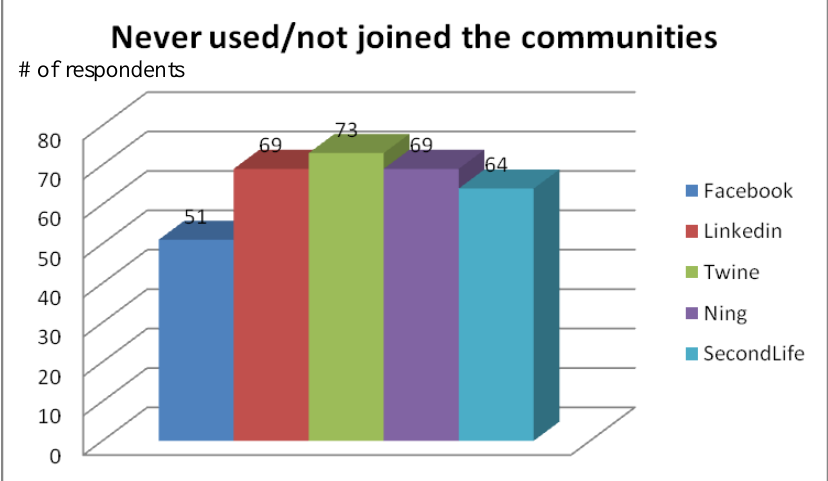
Figure 15 . Social networks never used ( N =